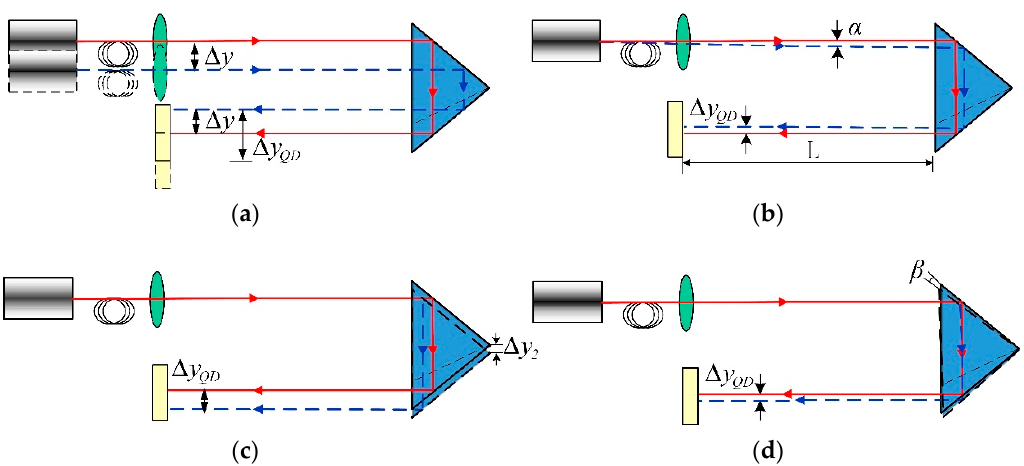
Figure 3. The optical path analysis diagram of laser collimation measurement system: ( a ) The schematic diagram of the vertical displacement of the sensor module; ( b ) The schematic diagram of the laser emission angle changes; ( c ) The schematic diagram of the vertical displacement of the reflection module; ( d ) The schematic diagram of the angle charge of the cube-corner prism.